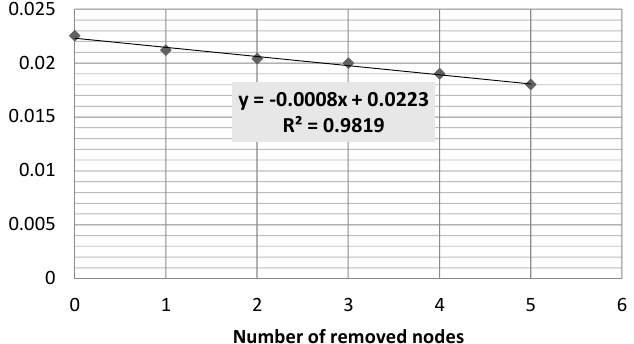
Figure 16. Changes of graph density.